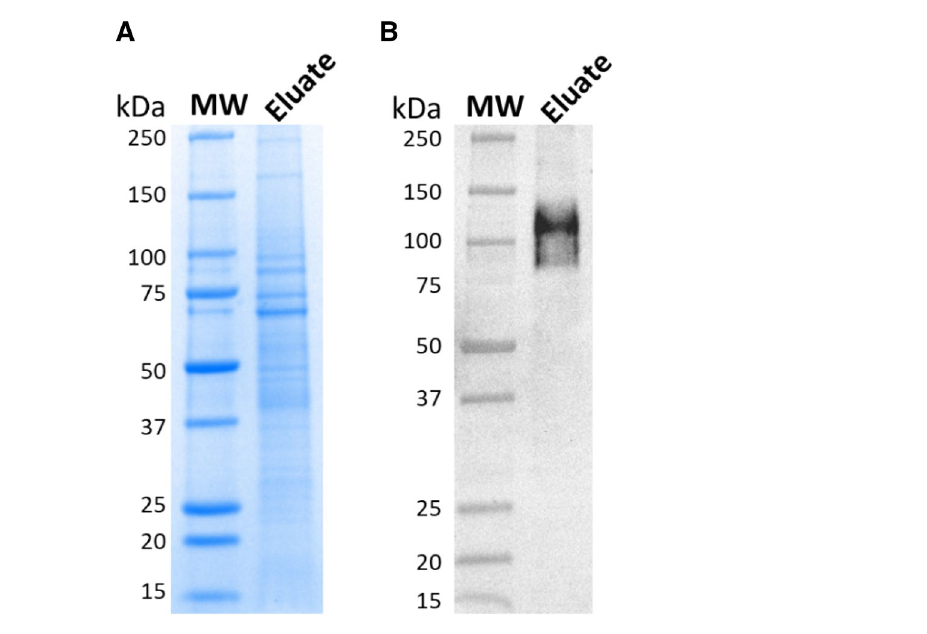
SDS-PAGE but not by western blotting (Fig. 5B,C). The total yield of the hTAS1R2 protein from peak 4 (frac- tions 14–16) resulting from sixty T225 flasks was approximately 135 µg (2.2 µg/flask, i.e., 0.08–0.1 µg/10 6 cells in terms of cell productivity).